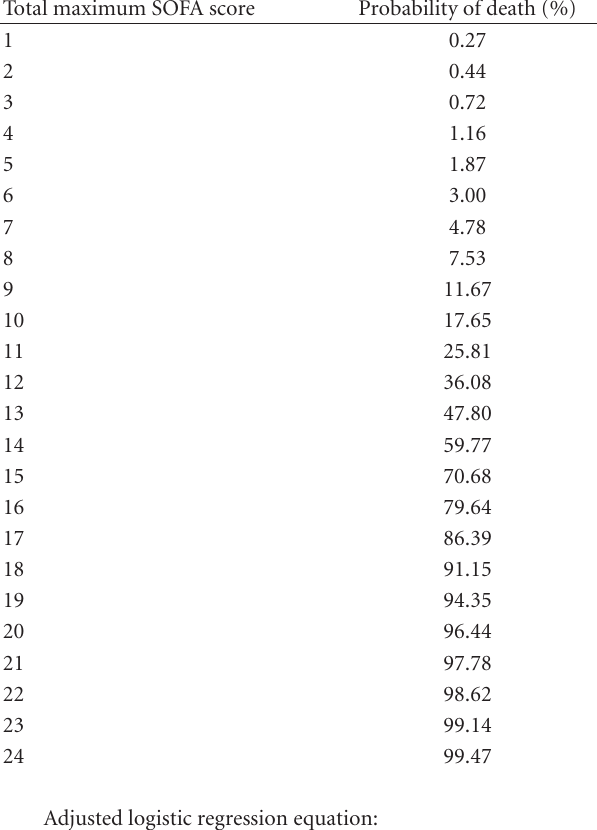
Table 2: Estimated probability of death of women with SMM, for each value of the total maximum Sequential Organ Failure Assess- ment score and the corresponding adjusted logistic regression equa- tion.